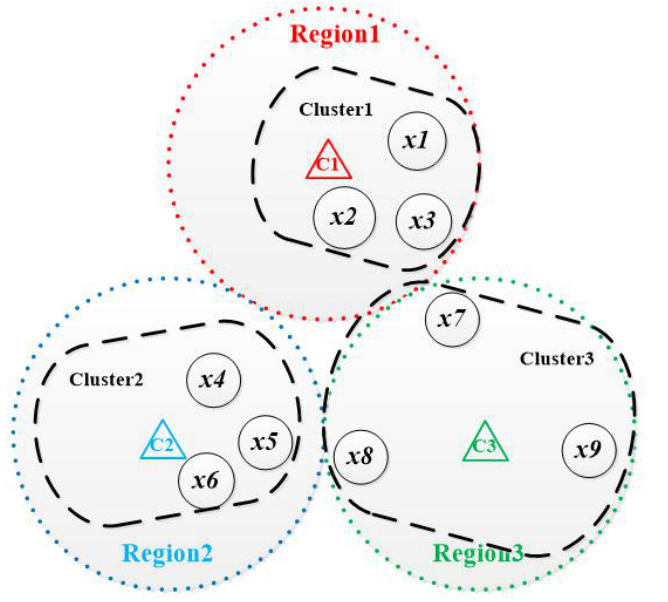
Figure 3. Clustering result by the improved clustering